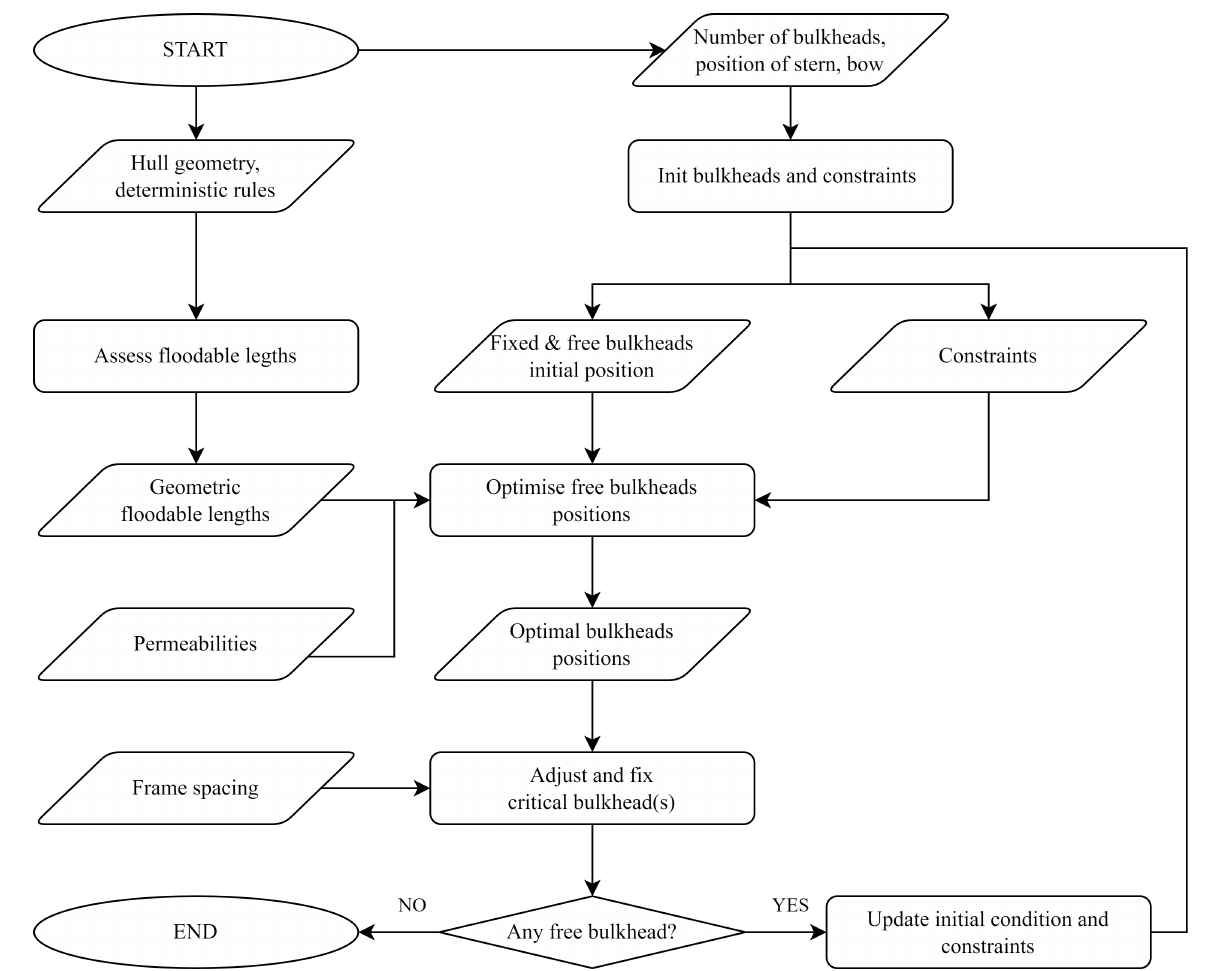
Figure 1. Applied multi-step optimisation